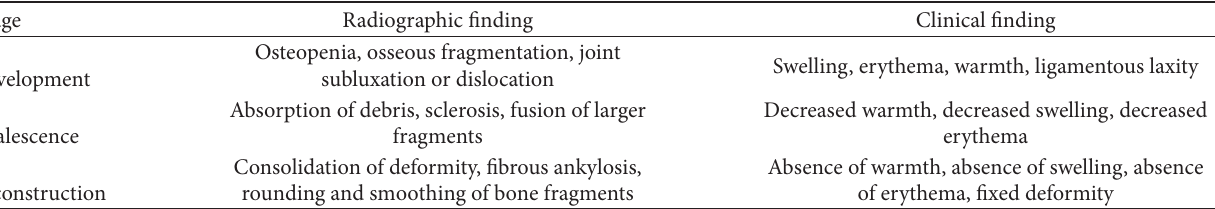
Table 1: Eichenholtz classification.